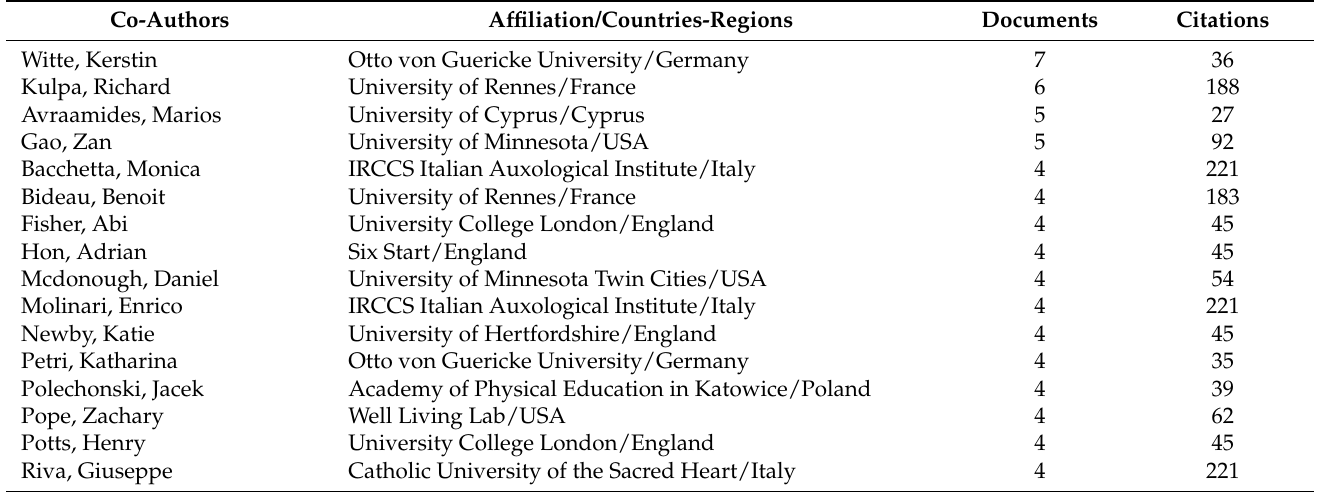
Table 3. Prominent co-authors on Virtual and Augmented Reality and Physical Activity.